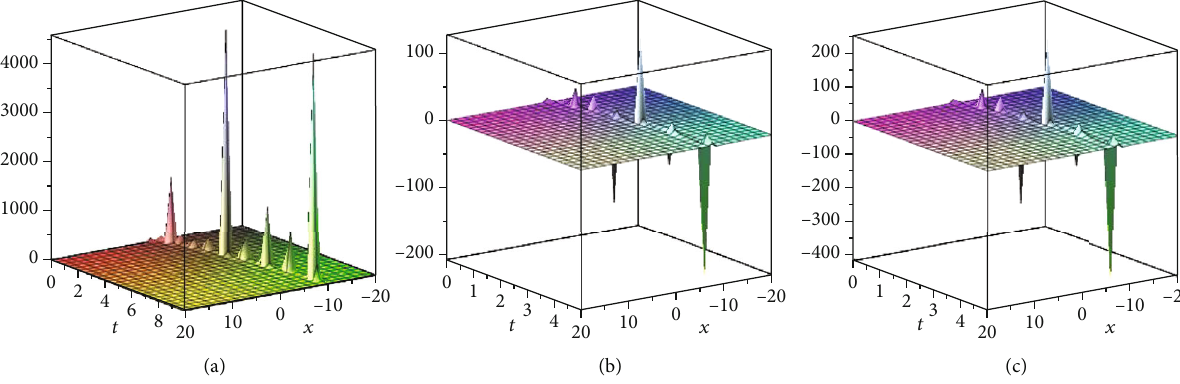
= b = τ = c = 1, and a − 1 0